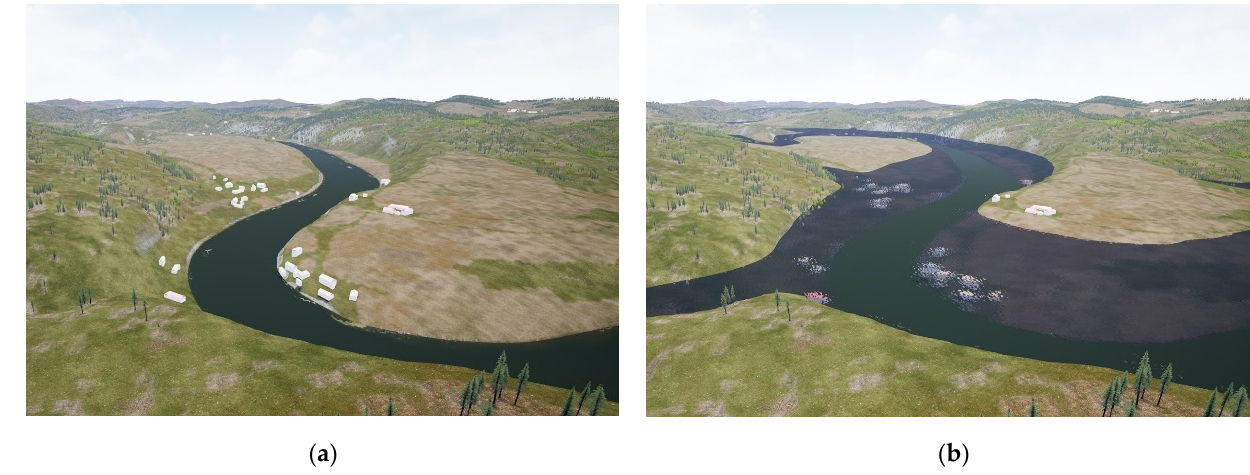
Figure 13. Virtual landscape model ( a ) before and ( b ) after reservoir filling.